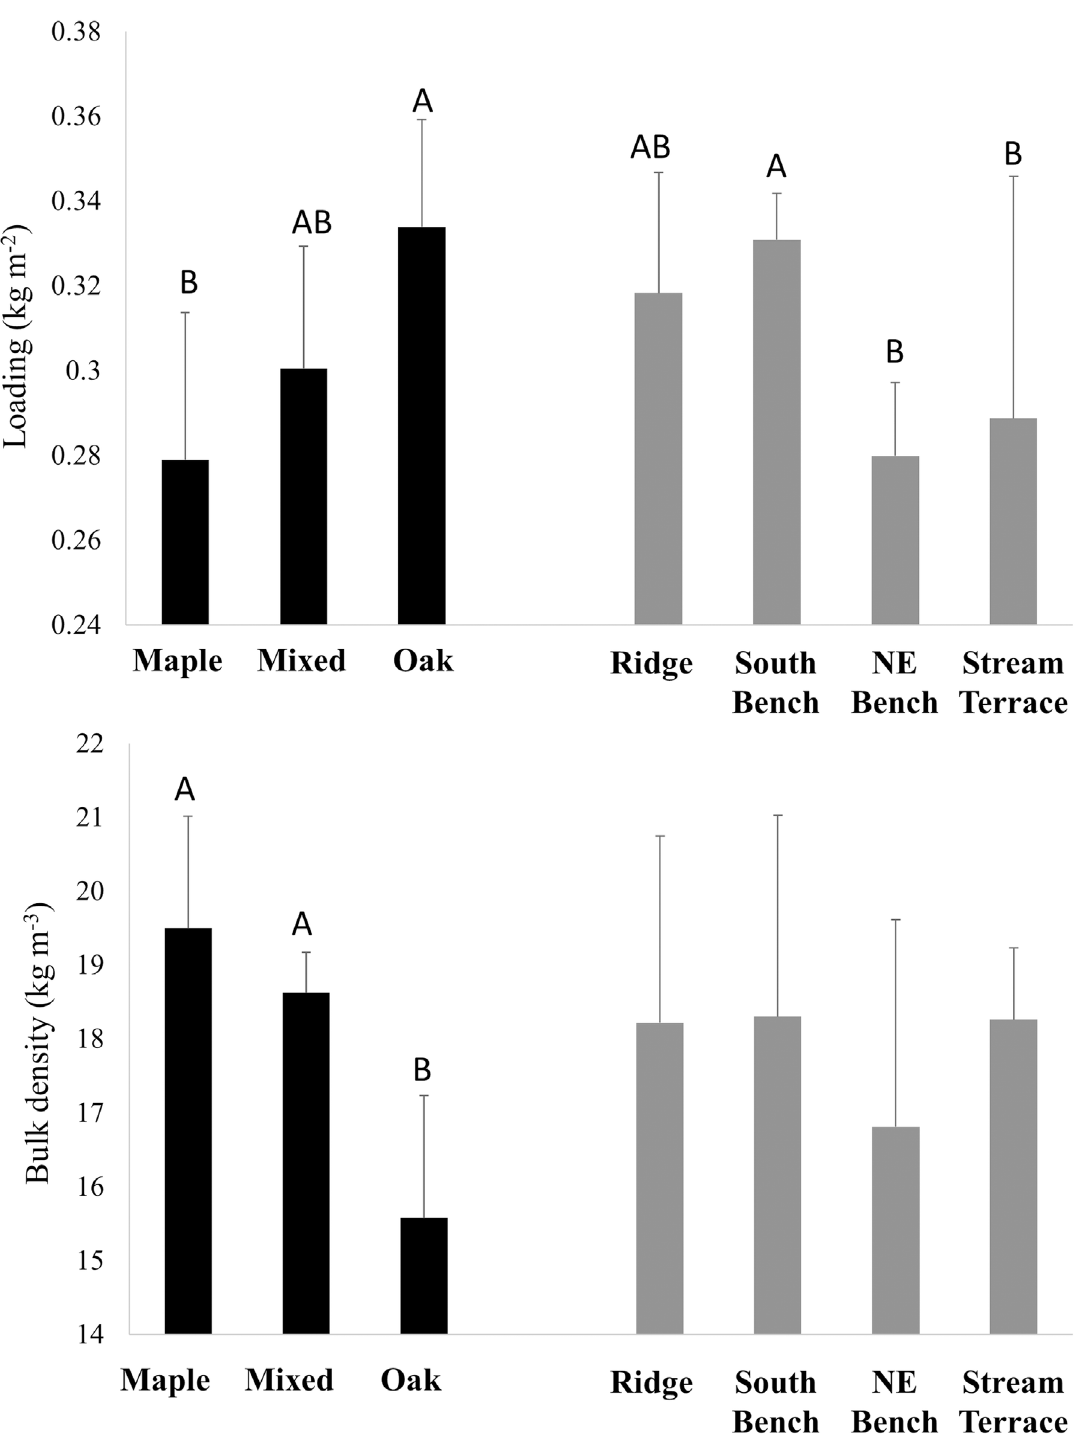
Fig 4. Common garden fuel loading and bulk density – L layer. Loading and bulk density by litter source and topographic position in common garden beds after four years of fall litter additions (see means in Table 3). Beds were sampled during the transition between winter and spring when most prescribed burning occurs. For significant main effects, differences among means were determined by Tukey ’ s HSD method and are indicated by different letters. Standard errors are shown.